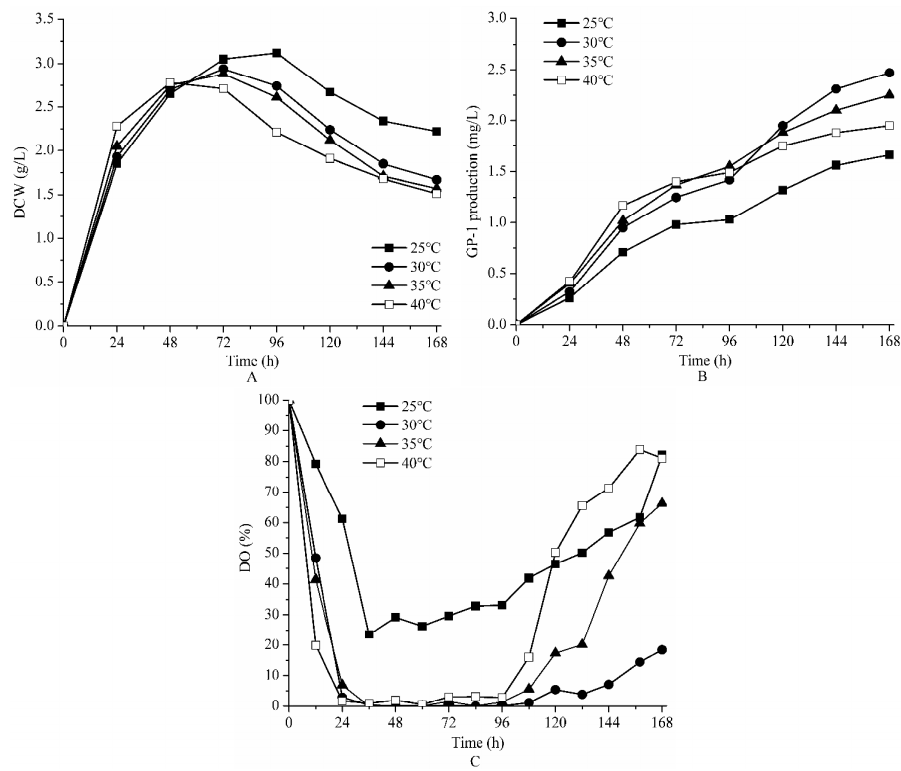
Figure 1. The effect of temperature on DCW ( A ); GP-1 production ( B ) and DO ( C ) during batch